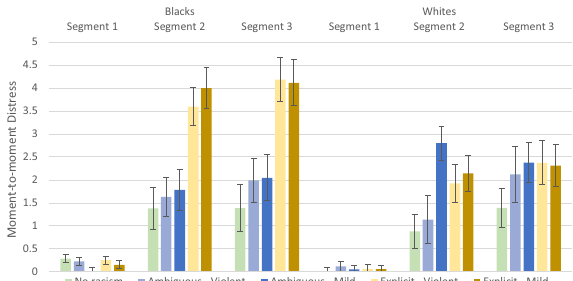
Fig. 4 Mean dial ratings ( + se ) of moment-to-moment distress indicated through each of the three video segments ( Y -axis) as a function of racist cues ( fi ve conditions) among Black (left) and White (right) participants. Overall, White participants indicated equal distress in response to violence.